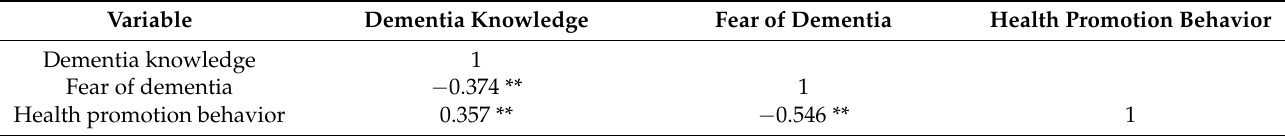
Table 3. Correlations among study variables ( N =